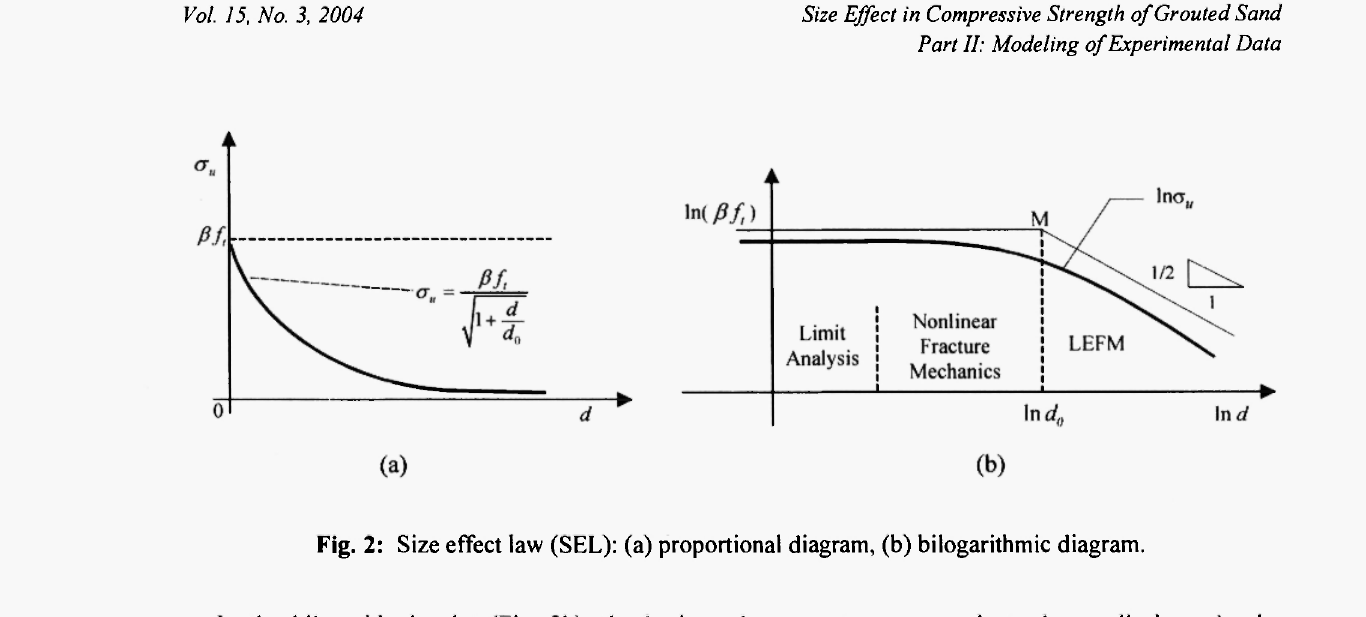
Fig. 2: Size effect law (SEL): (a) proportional diagram, (b) bilogarithmic